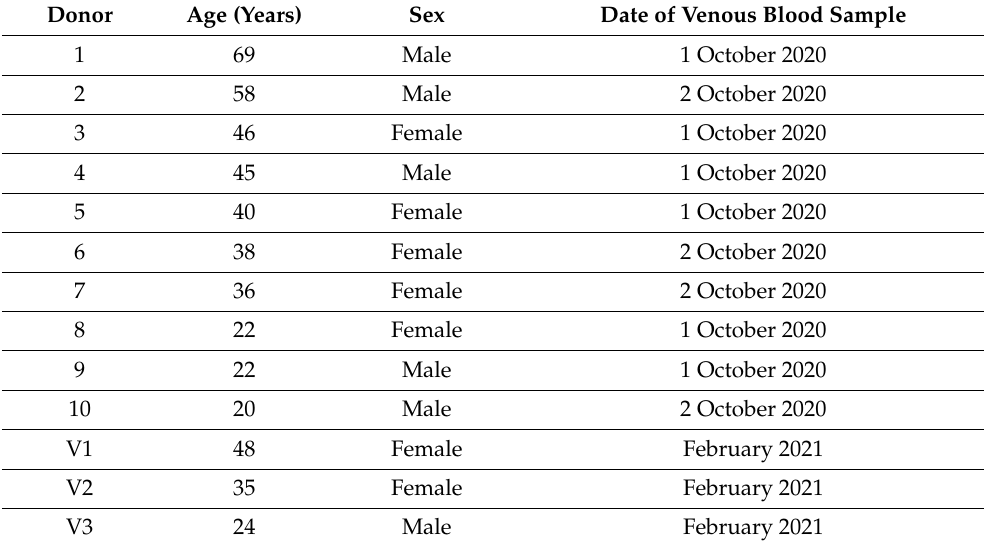
Table 2. Information regarding healthy donors (1–10) and vaccinated donors